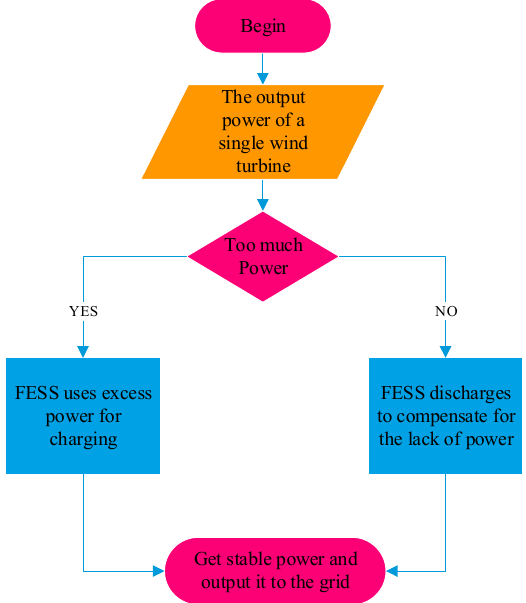
Figure 4. Wind power compensation flow chart.